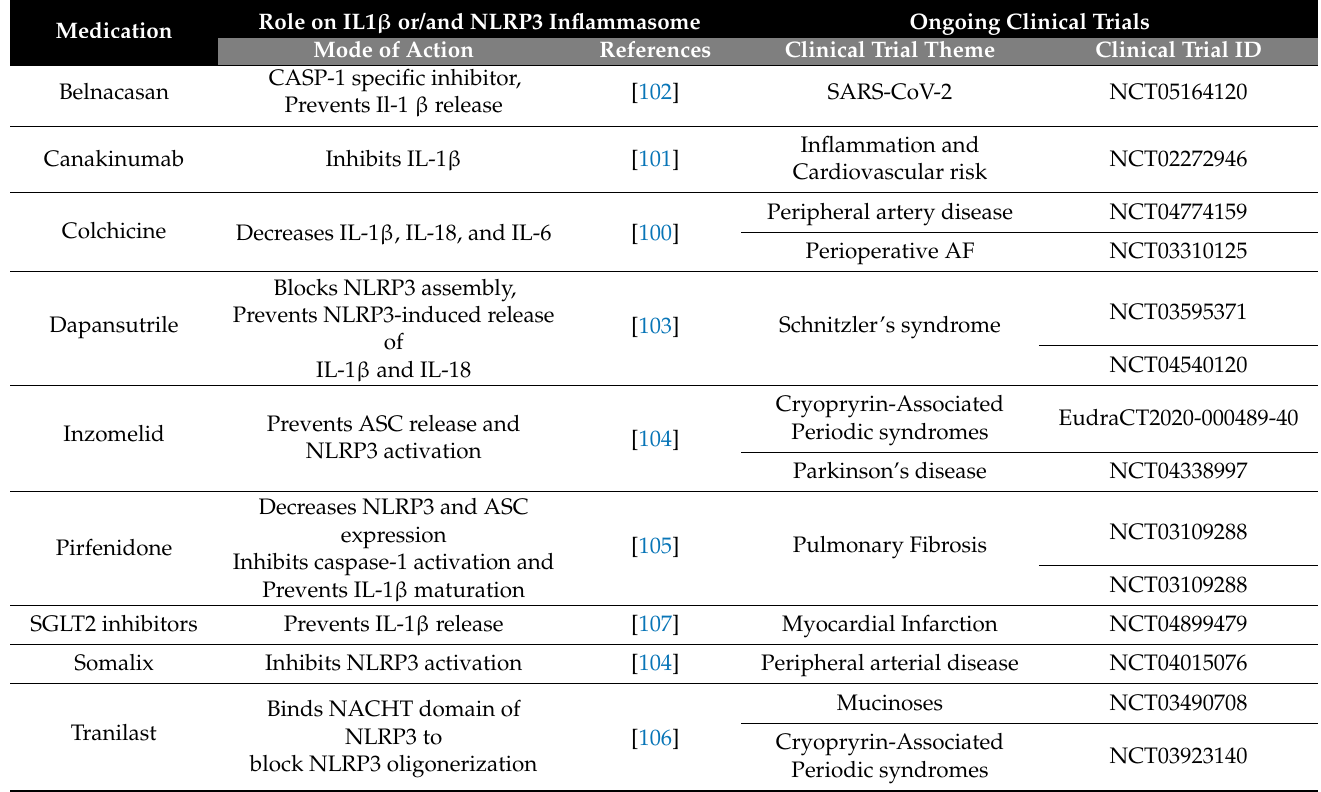
Table 1. A list of potential medications targeting key FRM-promoting molecules, currently tested in clinical trials. Available drugs are evaluated in ongoing clinical trials to determine their effects to inhibit NLRP3 inflammasome, IL1B, or IL18 in various conditions associated with an unresolved inflammatory